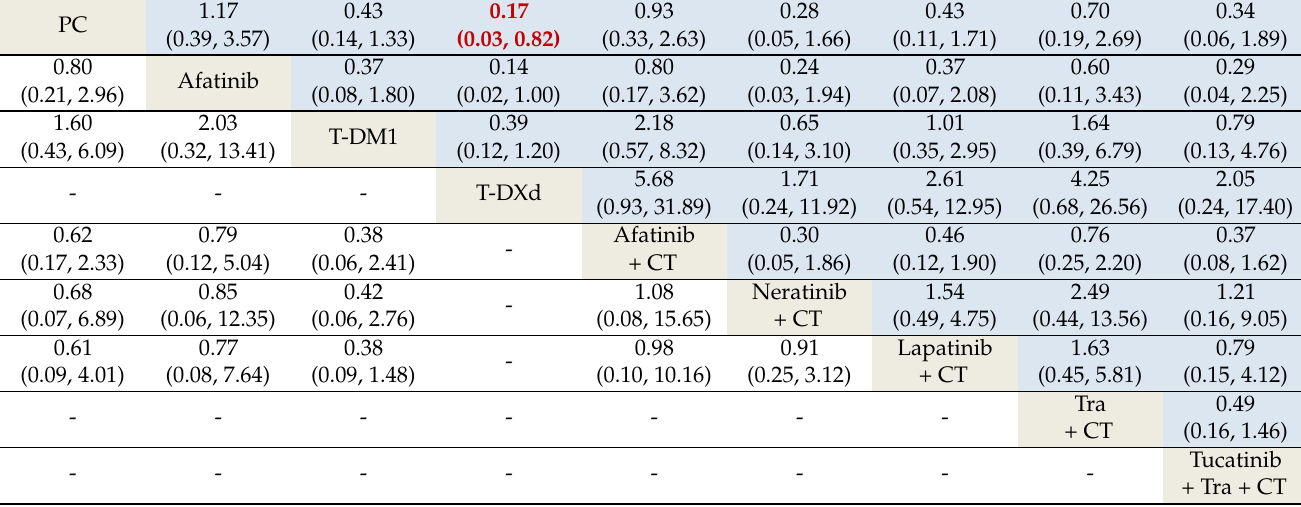
Table 3. Pairwise comparisons among nine interventions for PFS and OS (HR, 95% CrI).